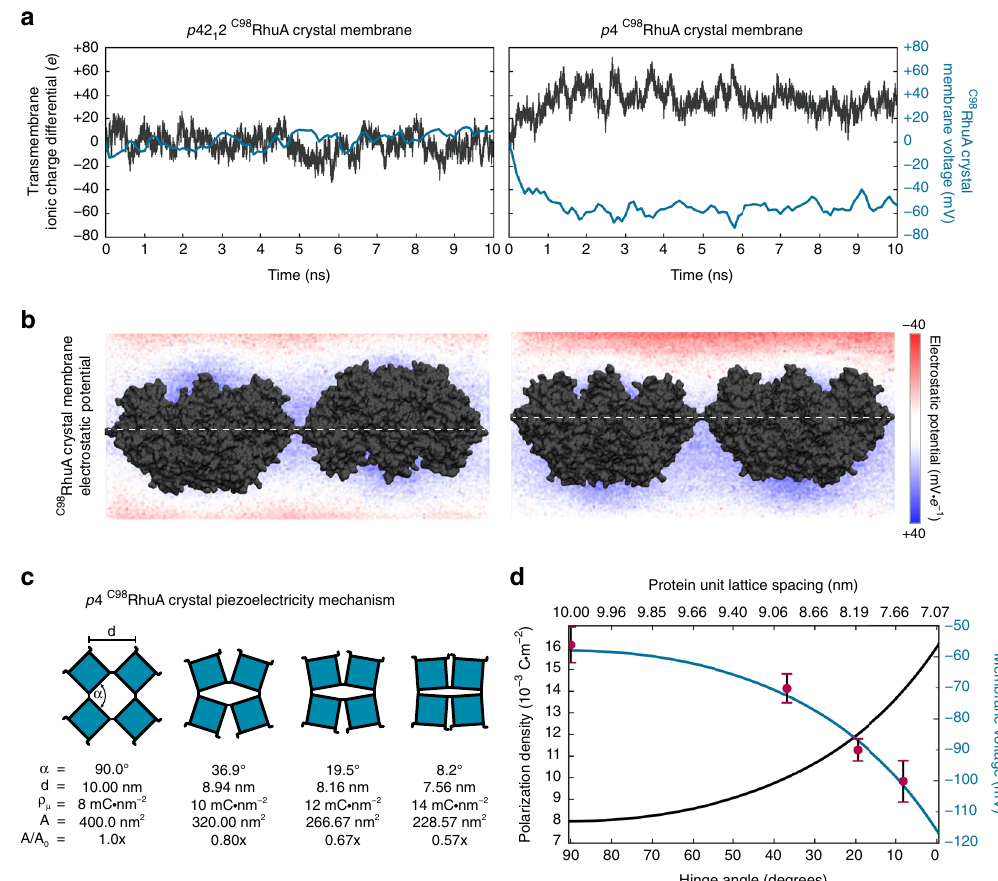
Fig. 5 p 4 C98 RhuA crystals are electrets and piezoelectric materials. a Net charge imbalance due to ion conduction across the disul fi de bonds (half of the simulation box) and resulting electric potential difference across open-state crystals. Dipole-less p 42 1 2 crystals induce negligible charge separation, while p 4 crystals generate a steady-state 50 – 60 mV potential difference across the lattice (membrane voltage). b Volumetric slices of the electrostatic potential across the central plane of each system directly illustrate the polarization. c Piezoelectric properties of p 4-symmetry C98 RhuA crystals, arising from mechanical coupling between the polarization density ( ρ μ ) and lattice conformation (left). The magnitude of this effect was predicted analytically (right) from the ρ μ over all lattice conformations (as de fi ned by the rotating squares model 7 ), while the points re fl ect numerically determined voltages from all- atom simulations at discrete conformations (Supplementary Fig. 15). The associated hinge angle ( α ), lattice spacing ( d ), ρ μ , and absolute (A) and relative (A/A 0 ) unit cell areas for each point are indicated at left. Error bars represent the s.d. of the membrane voltage over the last 5 ns of RhuA S98 Reverse: GGATGTGGTAACCTGCACCGCTGCTATCCACCTTAAC.